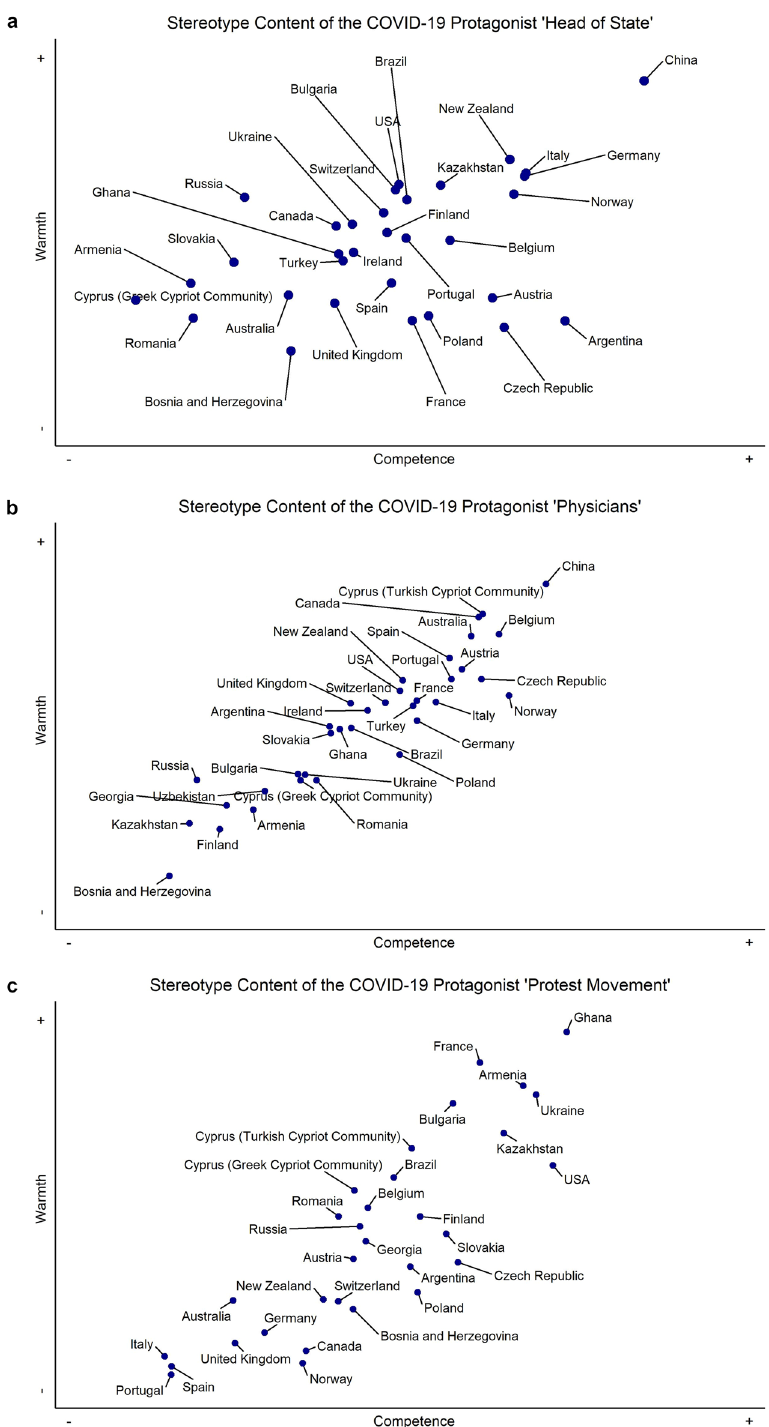
Figure 1. ( a ) The perception of the protagonist ‘heads of state’ on warmth and competence dimensions across countries. Note. Cyprus (Turkish Cypriot Community) was not included because there was no elected leader at the time of data collection. Georgia and Uzbekistan were not included due to poor model fit. ( b ) The perception of the protagonist ’physicians’ on warmth and competence dimensions across countries. ( c ) The perception of the protagonist ‘protest movements’ on warmth and competence dimensions across countries. Note. Protest movements were not perceived as relevant protagonists in China and Uzbekistan and thus not included in this research. Ireland and Turkey were not included due to poor model